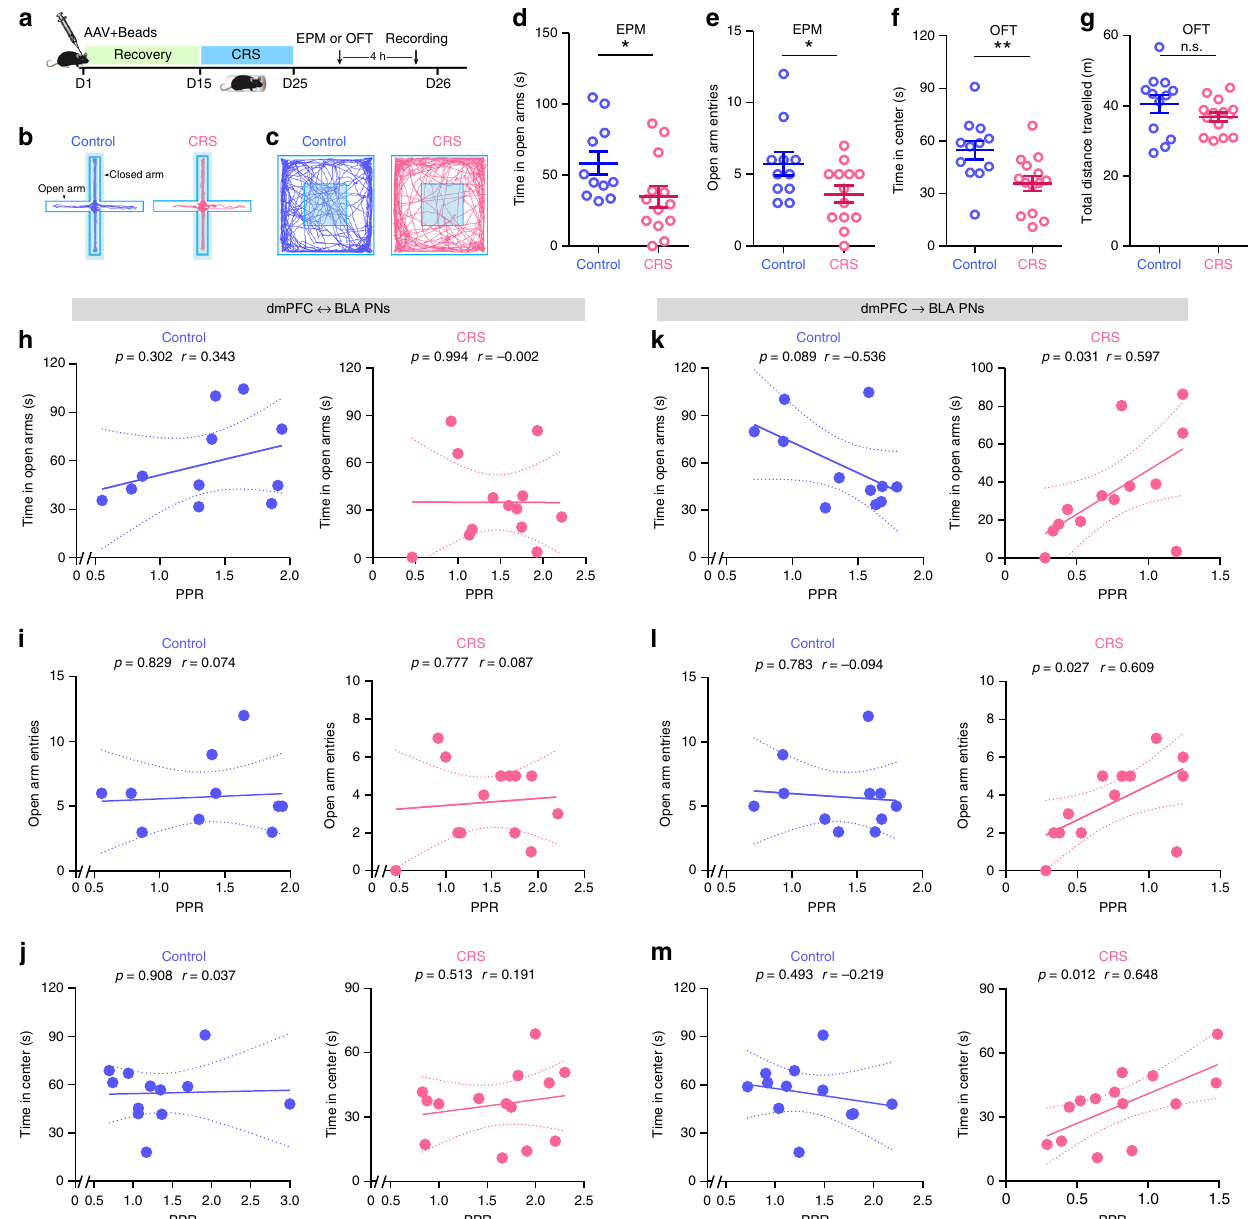
Fig. 5 Correlation between chronic stress-induced increase of prefrontal glutamate release and anxiety-like behavior in mice. a Schematic showing the experimental procedures. EPM elevated plus maze, OFT open fi eld test. b , c Representative activity tracking in EPM ( b ) and OFT ( c ). d , e Time in open arms ( d ) and open-arm entries ( e ) during EPM. Control, n = 11 mice; CRS, n = 13 mice. f , g Time in center region ( f ) and total distance traveled ( g ) during OFT. Control, n = 12 mice; CRS, n = 14 mice. h – j Correlations between the PPR in dmPFC ↔ BLA PNs and open-arm time ( h ) and entry ( i ) in EPM and time in center region ( j ) in OFT in control and CRS mice. k – m Correlations between the PPR in dmPFC → BLA PNs and open-arm time ( k ) and entry ( l ) in EPM and time in center region ( m ) in OFT in control and CRS mice. For d – g , data are presented as mean ± SEM, and the statistics are shown in Supplementary Table 1. n.s., not signi fi cant; * p < 0.05, ** p < 0.01. For h – m , linear regression analysis and Pearson ’ s correlation were performed (two tailed). Source data are provided as a Source Data fi